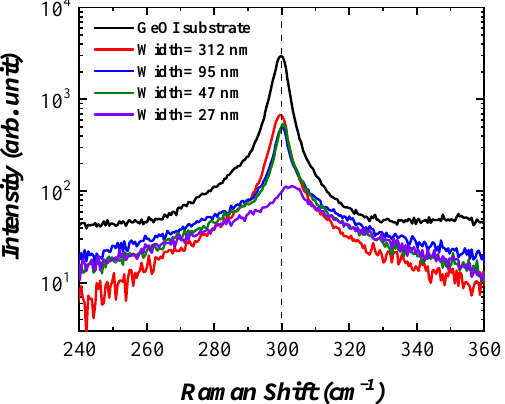
Figure 3. Raman spectra of GeOI substrate and GeNWs with the incident power of 3.2